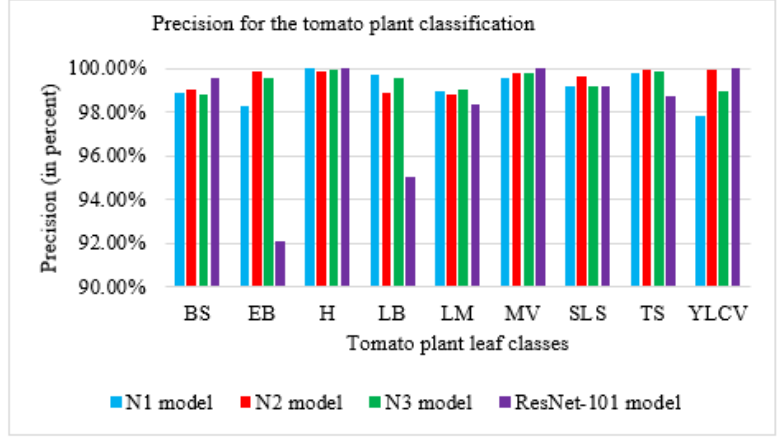
Figure 11. Precision performance for TPL classes.